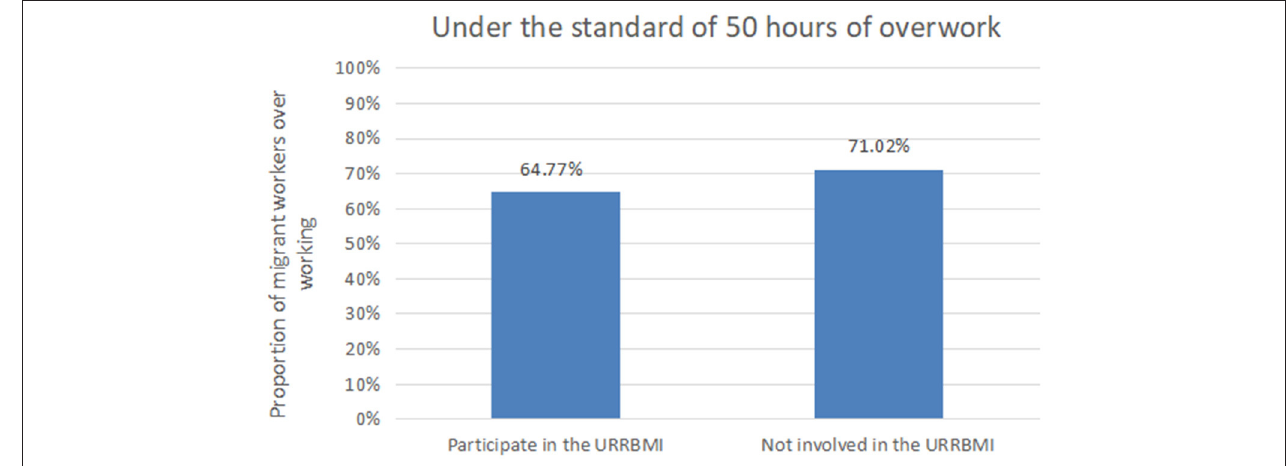
FIGURE 2 | Proportion of migrant workers’ overwork under 50h standard.